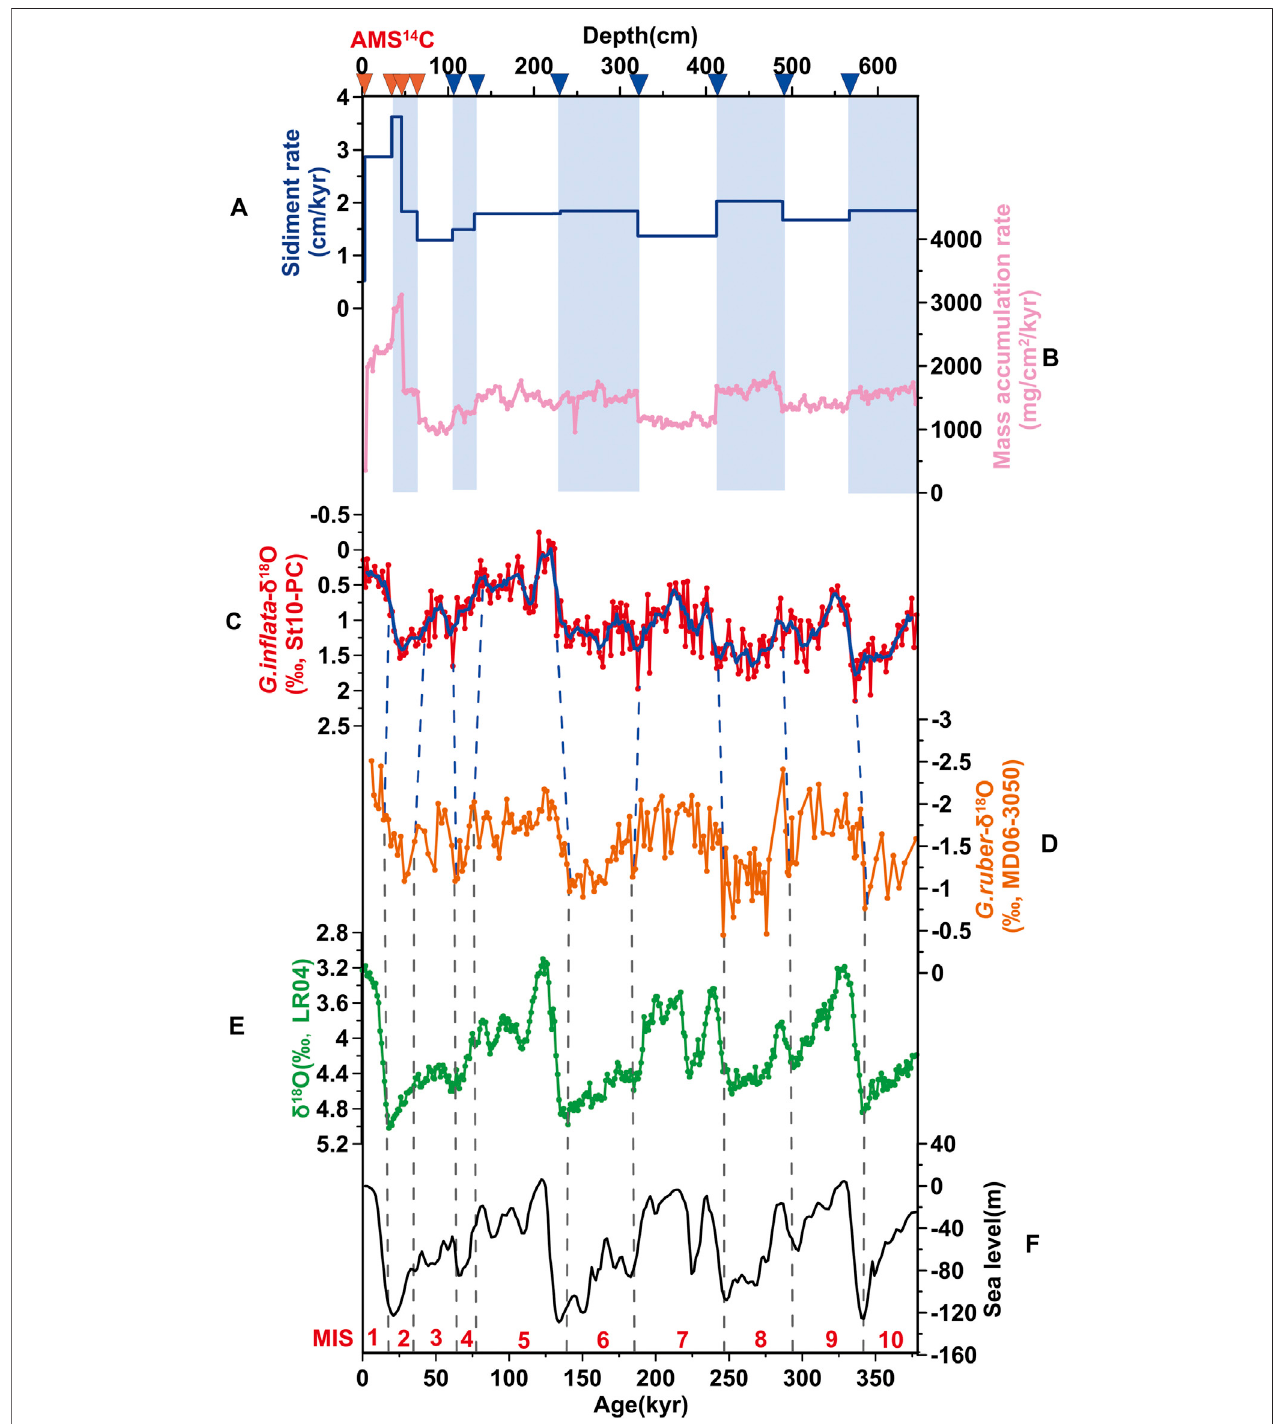
FIGURE2| StratigraphicagemodelofcoreSt10-PC. (A) sedimentaryrateofcoreSt10-PC, (B) themassaccumulationrateofcoreSt10-PC, (C) G.in fl ata - δ 18 Oof core St10-PC with a 5-point running average (blue line) (Zhang et al., 2020), (D) G. ruber - δ 18 O of core MD06-3050 (Sun et al., 2011), (E) LR04 benthic- δ 18 O stack (Lisiecki and Raymo, 2005), (F) the global sea level variations (Waelbroeck et al., 2002). Orange and blue trangles: age control points of AMS 14 C dating and G. in fl ata - δ 18 O records of core St10-PC, respectively; blue shadow: glacial periods.